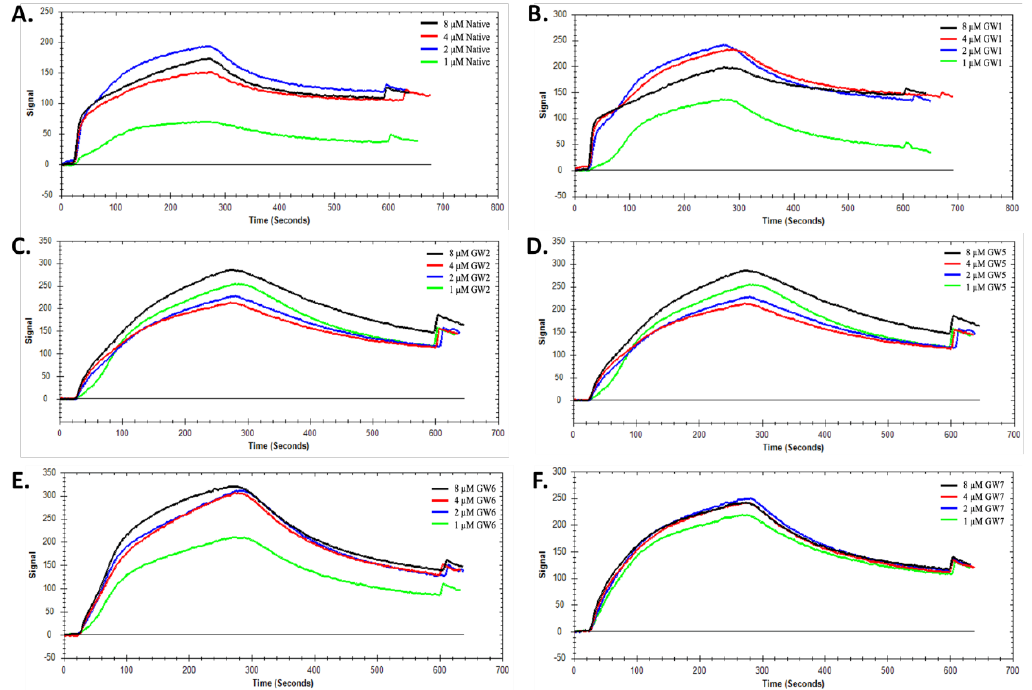
Figure 3. SPR kinetic analysis of ( A ) native TBA, ( B ) 5TG, ( C ) 5LTG, ( D ) 4NHT, ( E ) 13NHT, and ( F ) 413NHT TBA constructs.